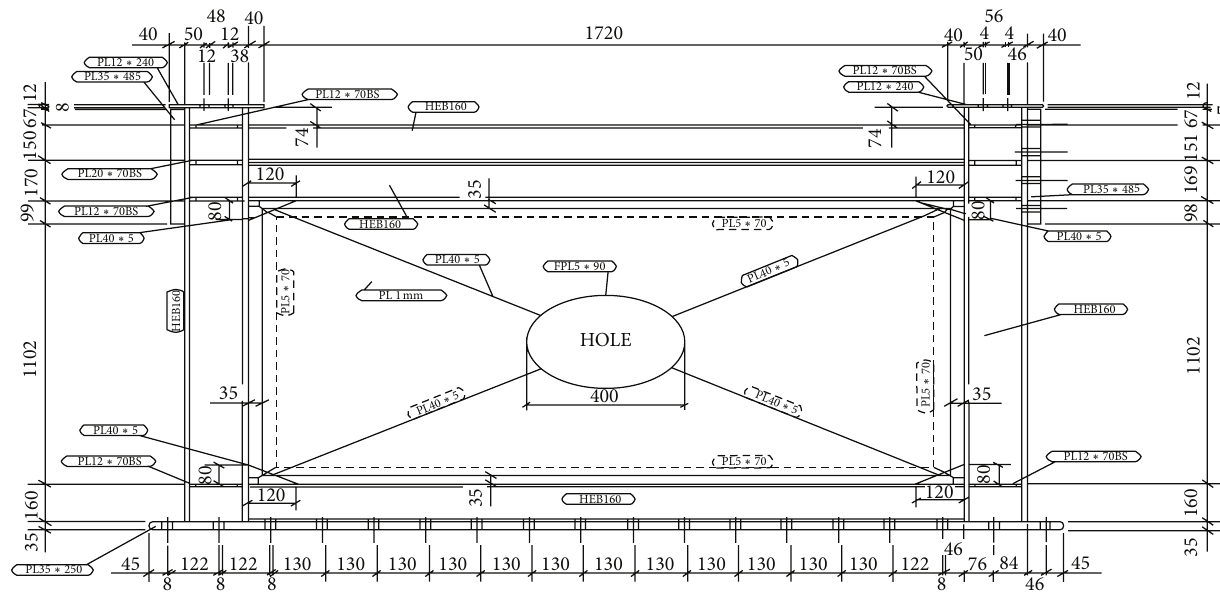
Figure 1: Perforated specimen SPSW(s 4 ) details [12]. Table 1: Mechanical proprieties of steel materials from the tension coupon tests